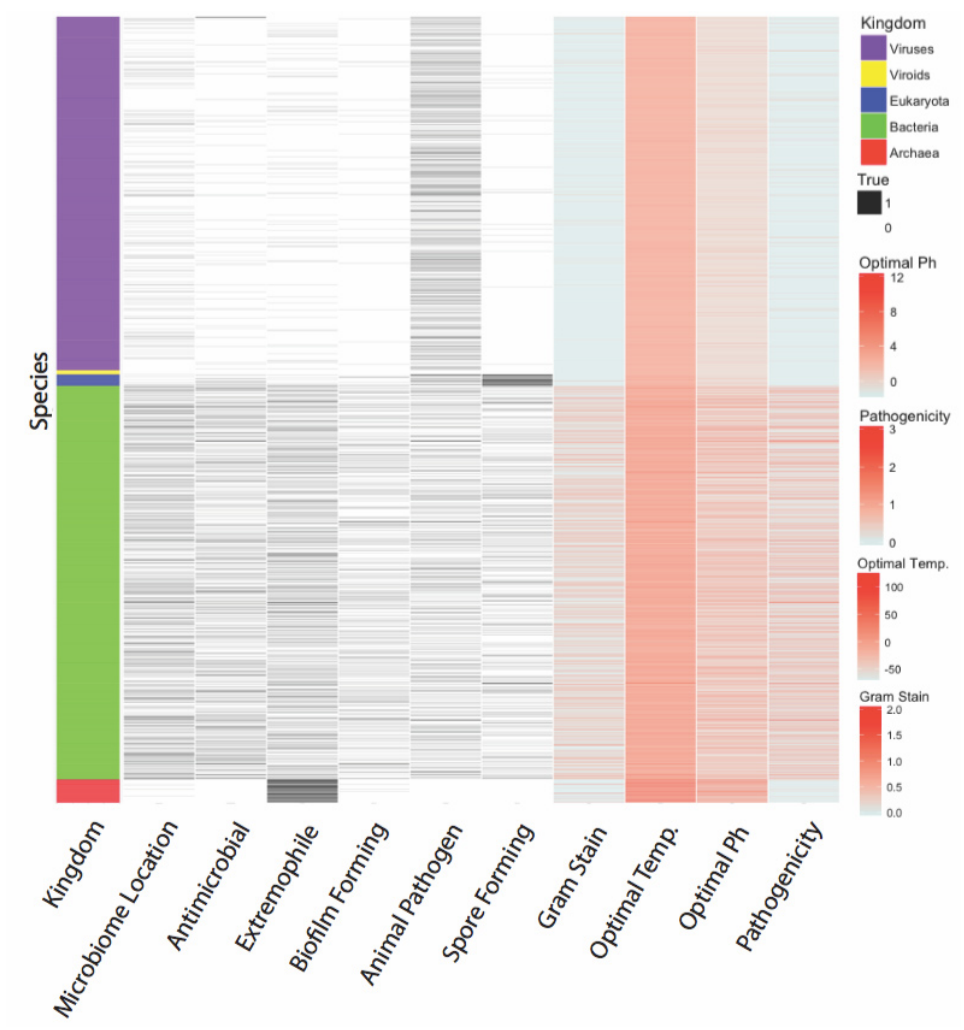
Figure 1. Microbe Directory heatmap. Annotation types (x-axis) are represented across the online database and the numbers of each category (y-axis, left side) are shown, including Viroids (purple), Viruses (yellow), Eukaryotes (blue), Prokayotes (green), and Fungi (red). The scale for each of the types of metadata (right) are also shown for binary classifications (black, white) and quantitative traits (red scales). Heatmap was constructed using R (version 3) and